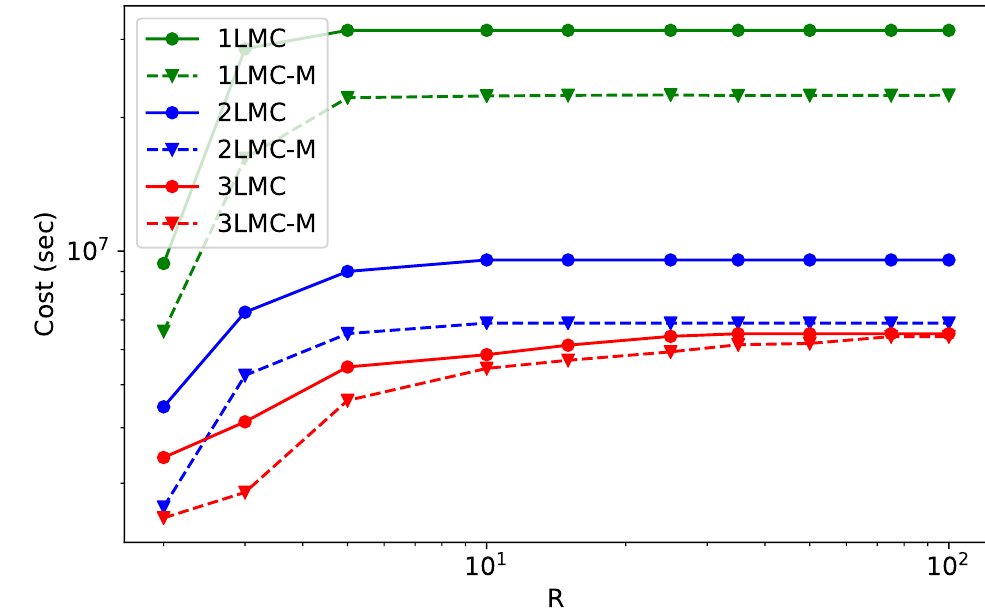
Figure 5. Computational costs of different Monte Carlo methods and number of moments R . XLMC denotes MLMC of X levels, whereas XLMC-M has an additional